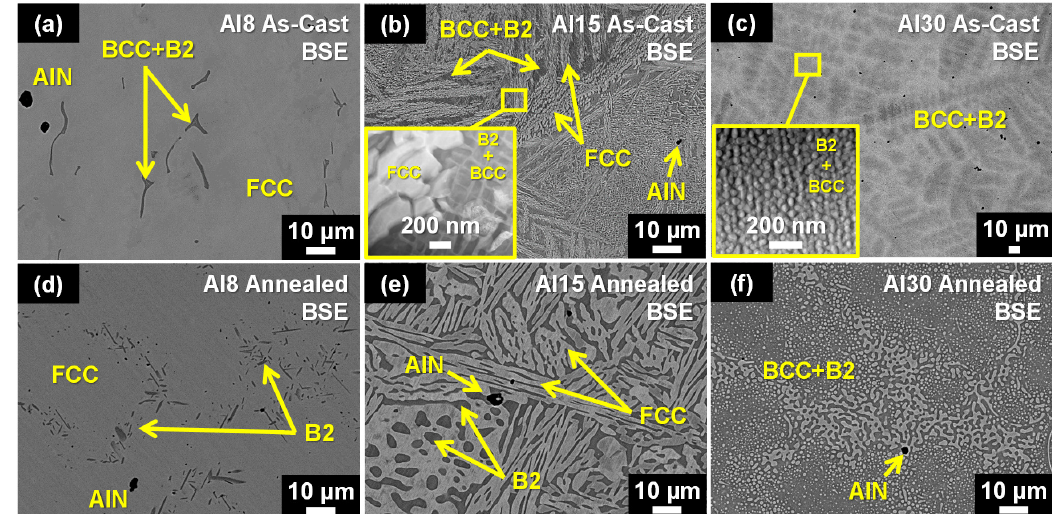
Figure 1. Representative backscattered electron (BSE) images of the Al 8 , Al 15 , and Al 30 high-entropy alloys (HEAs) in as-cast ( a – c ) and annealed ( d – f ) conditions, respectively. The inset images in ( b , c ) are higher resolution scanning-transmission electron microscopy-high angle annular darkfield (STEM-HAADF) images of the Al 15 and Al 30 HEAs. The as-cast BSE images are taken from [7,15].